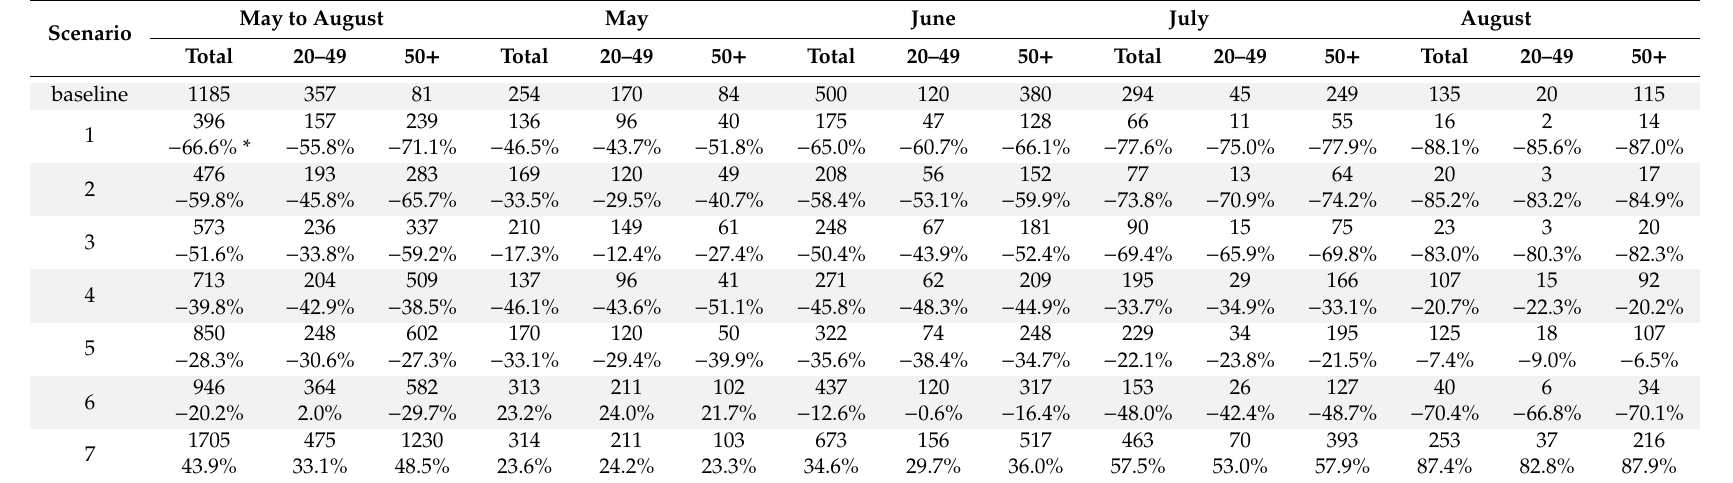
Table 8. Monthly incidence of the total age group, the age groups of 20–49, and those 50 years and older (50 + ) for all scenarios. The percentage below incidence represents the percentage increase or decrease from the